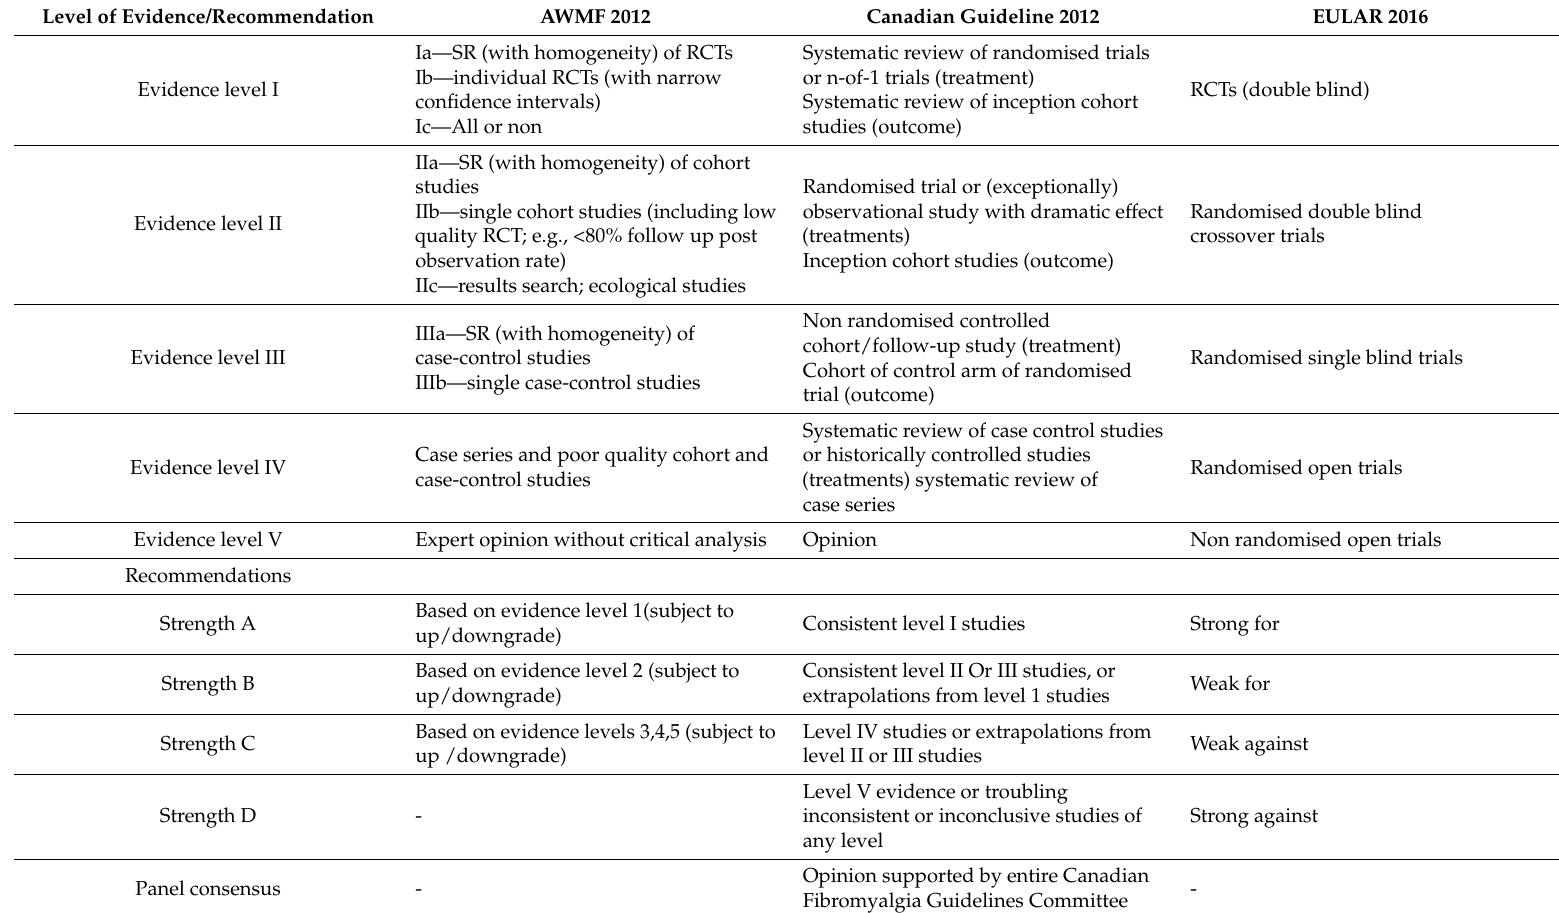
Table 1. Comparison of the categorization of evidence and recommendations of the four guidelines used for therapy/prevention/aetiology and adverse reactions. Level of